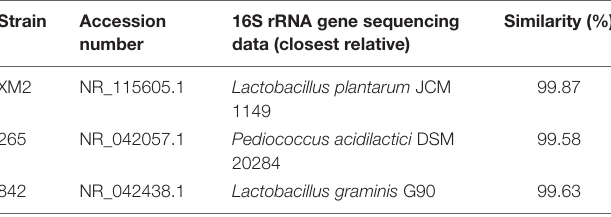
TABLE 3 | The results of isolated lactic acid bacteria on the base of 16S rRNA gene sequences.